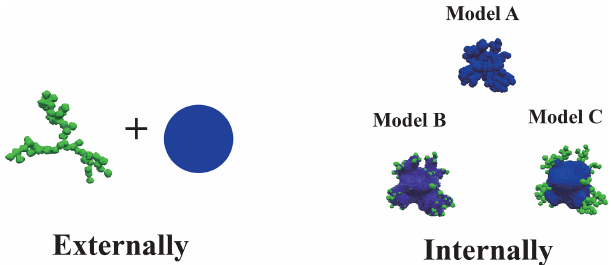
Figure 3. BC morphologies considered in this work. The internally mixed particles were generated using the models developed by Luo et al.